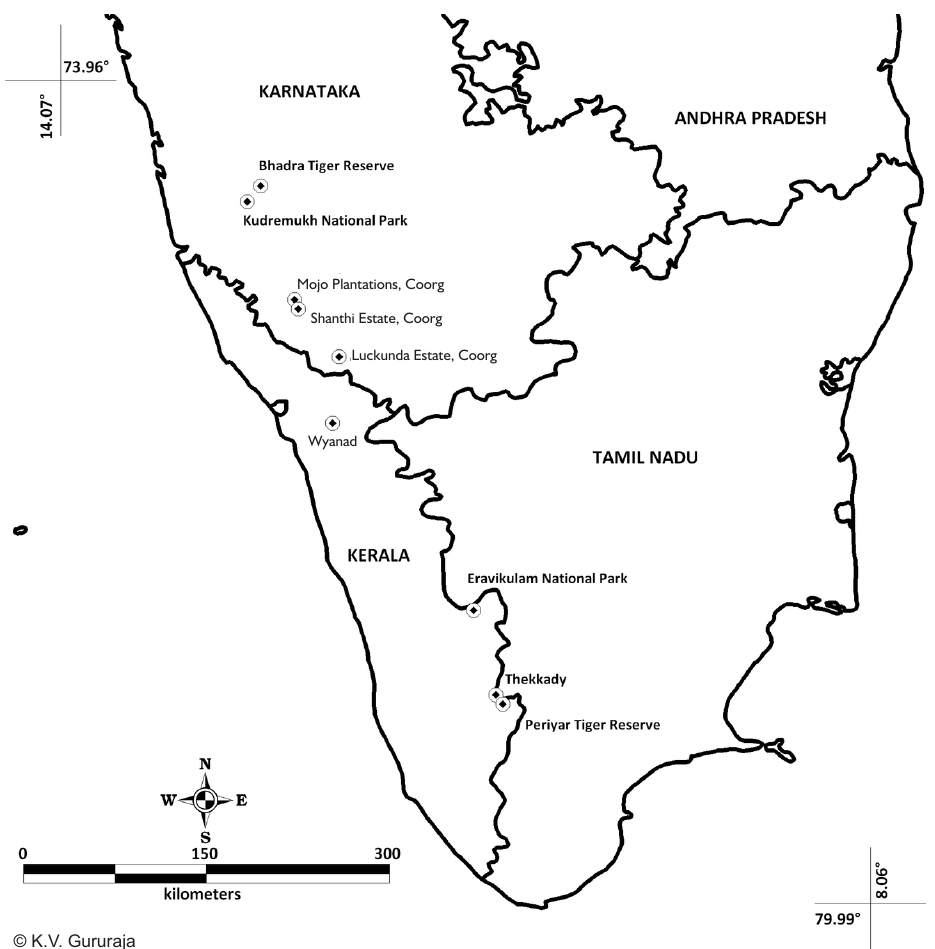
Figure 1. Map showing the locations where Rhacophorus lateralis has been recorded in Western